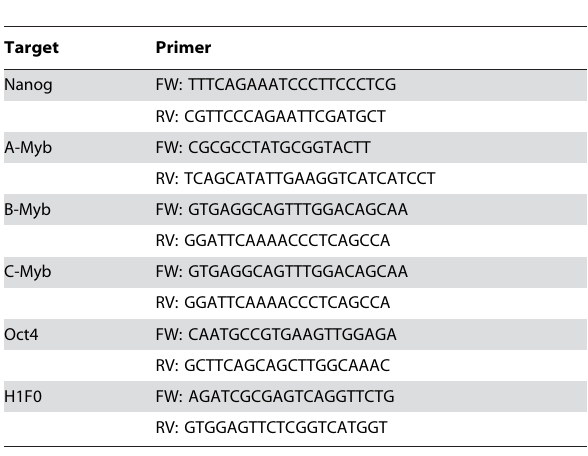
Table 4. Primers used for qRT-PCR